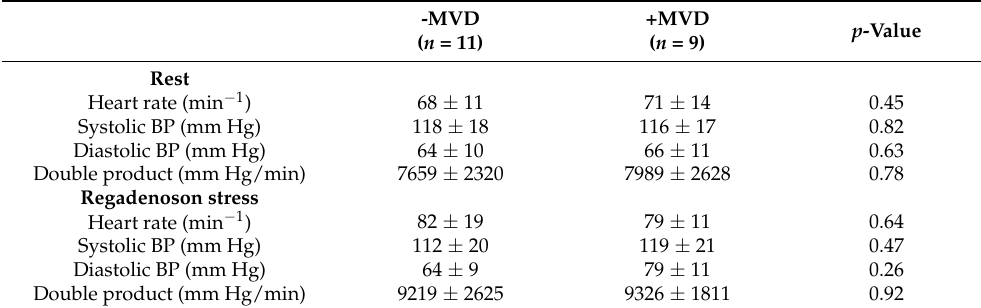
Figure 1. Contrast echocardiography data (mean ± STD) at rest and during regadenoson stress stratified according to presence of microvascular dysfunction (+MVD). Data include ( A ) microvascular blood volume, ( B ) microvascular flux rate, and ( C ) microvascular blood flow calculated by the product of microvascular blood volume and flux rate. Data from all subjects are shown. Vital signs at rest and during vasodilator stress by presence of microvascular dysfunction (MVD).